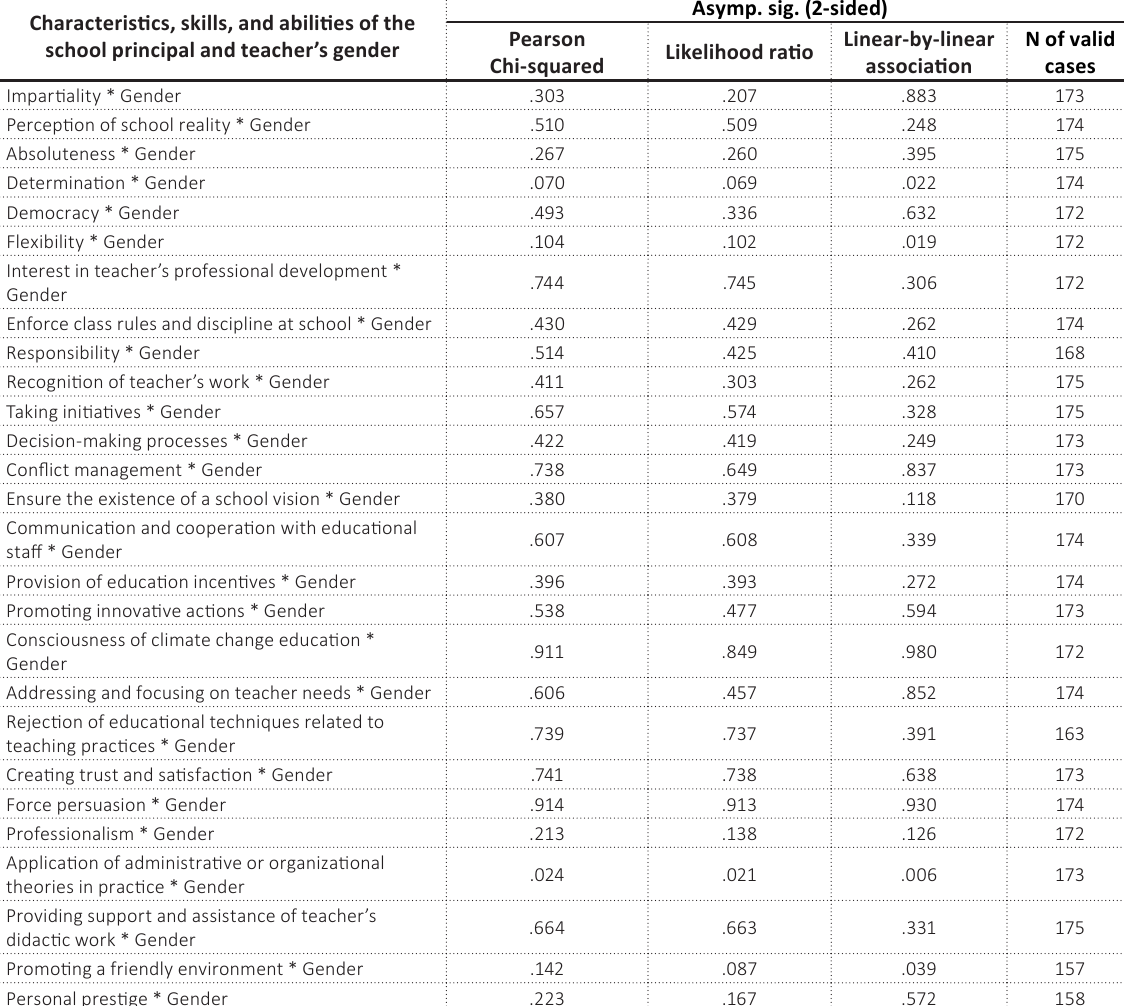
Table 4. Chi-squared analysis for hypothesis H